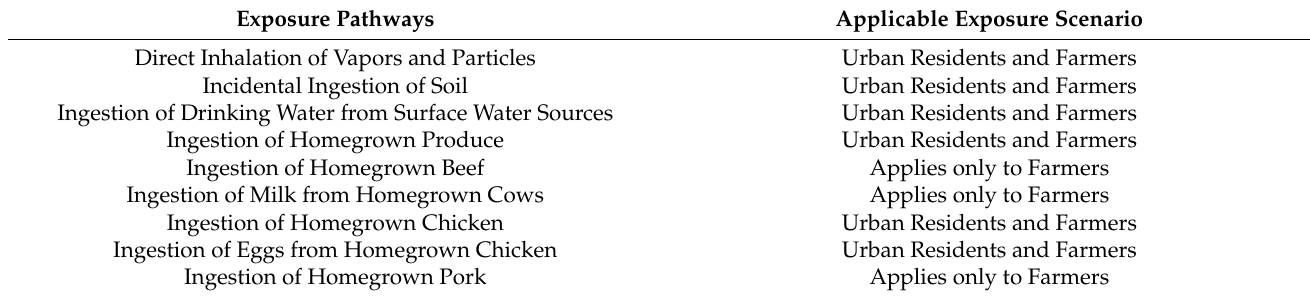
Table 4. Evaluated Exposure